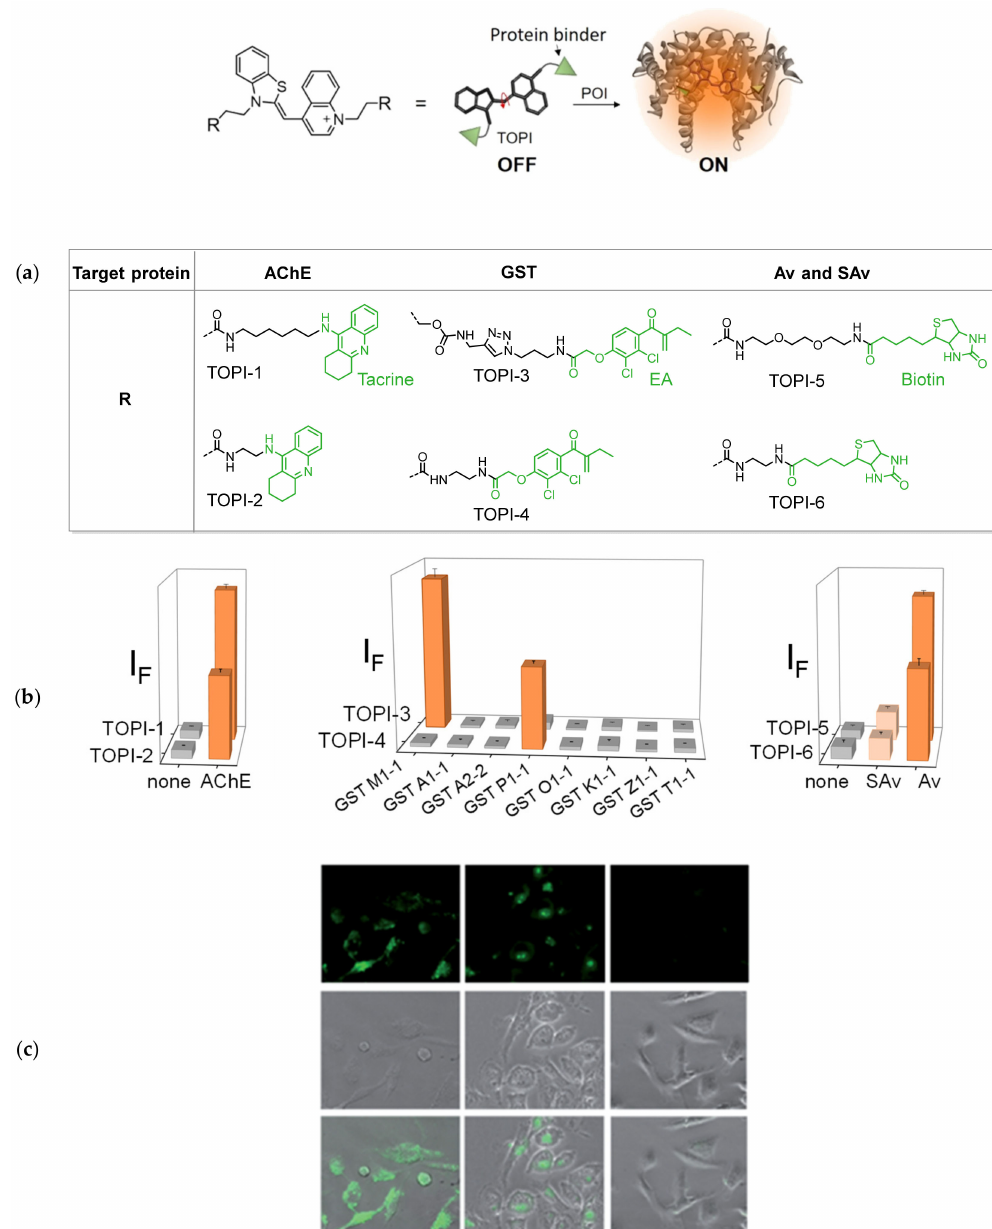
Figure 13. Protein sensing by TOPI probes. ( a ) The work mechanism of TOPI probes (top). TO is flanked on both ends by protein binders. Binding induces an interaction between TO and the POI’s surface, which restricts TO’s motion and yields increased fluorescence. Also shown (bottom) are the chemical structure of TOPI probes targeting different protein families; ( b ) The fluorescence responses of TOPIs to their protein targets; ( c ) Fluorescence (top), bright field (middle), and overlay (bottom) images of MDA-MB-231 cells overexpressing GST-P1-1, after incubation with TOPI-4 (left), TO (center), and TOPI-4 mixed with EA (right). Reproduced and adapted with permission from [175]. Copyright 2015 Royal Society of